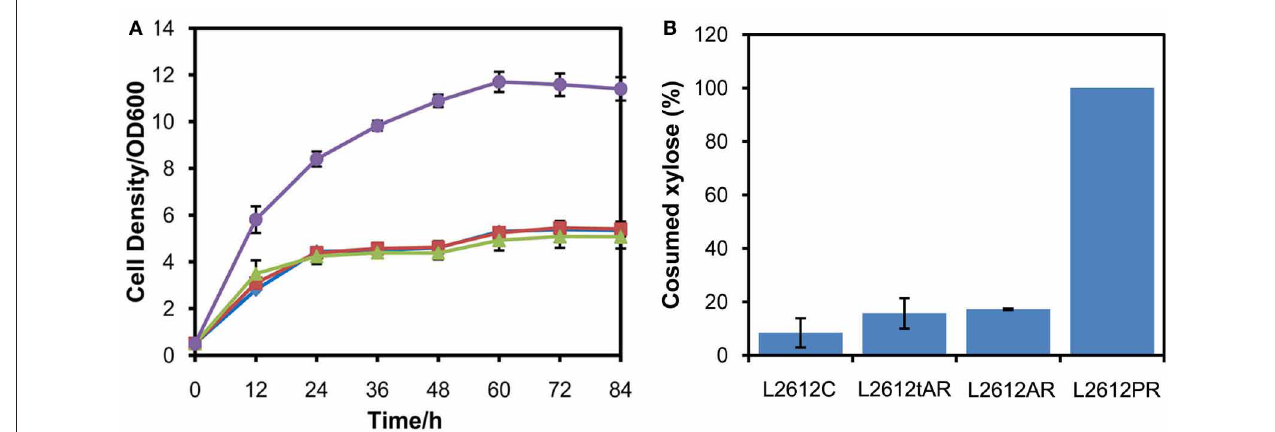
FIGURE 3 | Comparison of growth profiles (A) and xylose uptake capacities (B) of three recombinant strains derived from yeast strain L2612 and control strain L2612C in YPX medium under aerobic conditions. Symbols: squares, L2612C; diamonds, L2612tAR; triangles, L2612AR; circles, L2612PR. Strains L2612tAR, L2612AR, L2612PR were